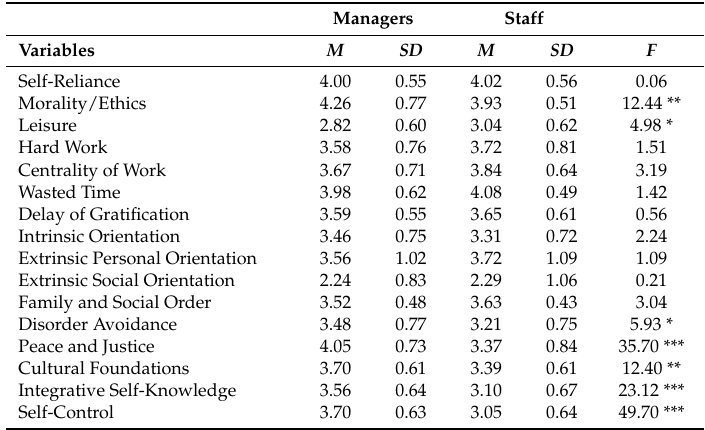
Table 5. Comparisons between Executives and Staff on Work Ethics, Religious Orientations. Integrative Self-Knowledge, and Self-Control. Managers